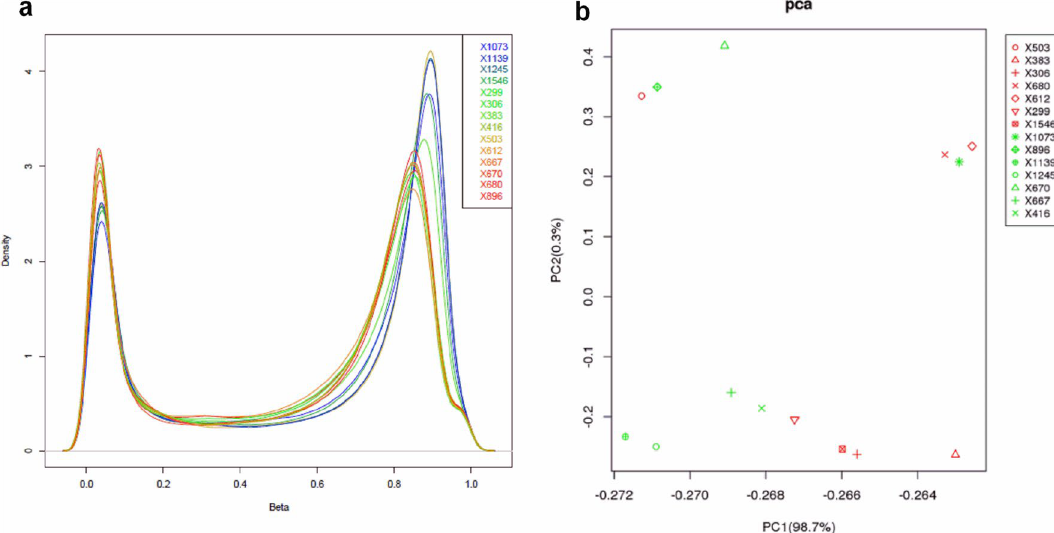
Figure 1. Statistical methylation patterns of cases and controls. ( a ) Density plot of β-values for all probes in the EPIC arrays for all 14 individuals. ( b ) PCA of whole DNA methylomes allows for the differentiation between ADLI cases (N = 7, red shapes) and matched controls (N = 7, green shapes).